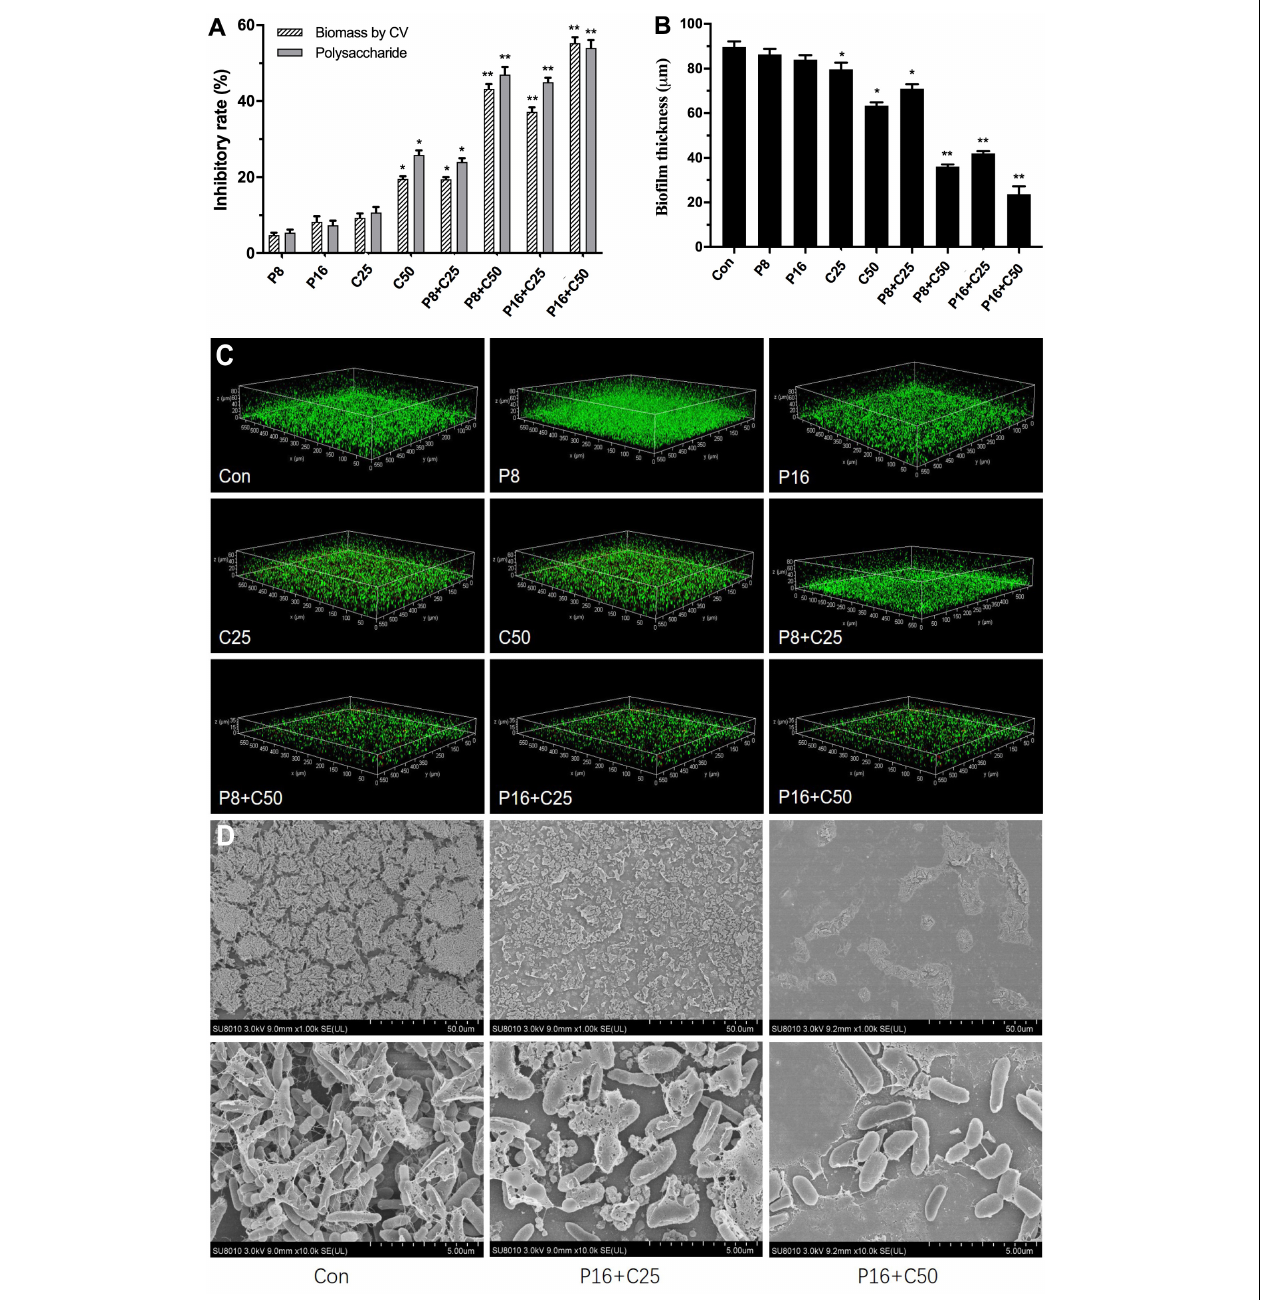
FIGURE 3 | Effects of ε -PLH combined with CEOs on the biofilm formation, polysaccharides, and spatial structure of L. monocytogenes and P. lundensis as co-culture. (A) Biofilm biomass by CV, (B) polysaccharides production, (C) CLSM images, and (D) SEM images. Data were expressed as mean ± standard deviations ( n = 3). * p < 0.05; ** p < 0.01: significant interspecies